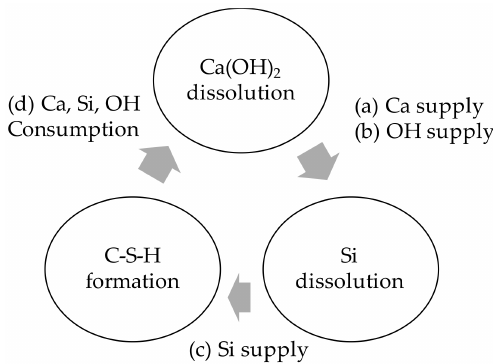
Figure 13. Schematic mechanism of C-S-H formation cycle.